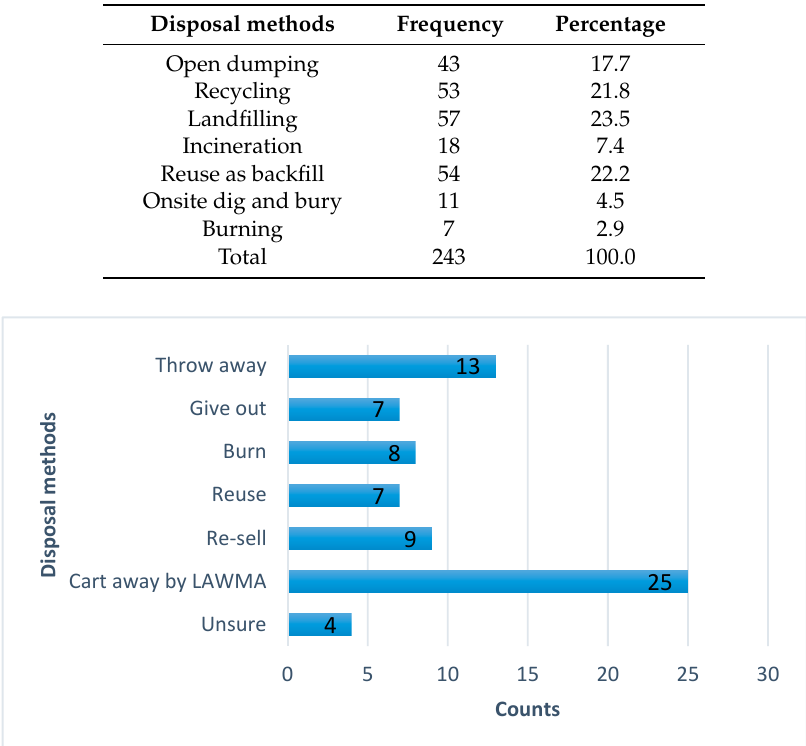
Table 5. Disposal methods, as indicated by the questionnaire survey.